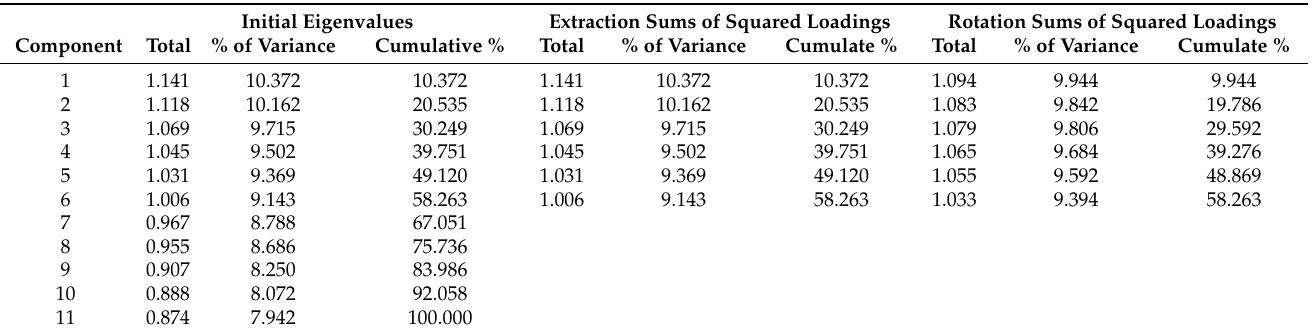
Table 9. Calculation of the total explained variance with two components in an accumulated percent- age of